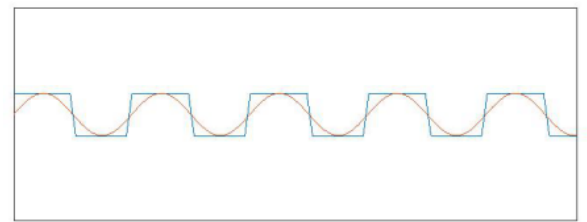
Figure 3: Graphical steps and their fitting